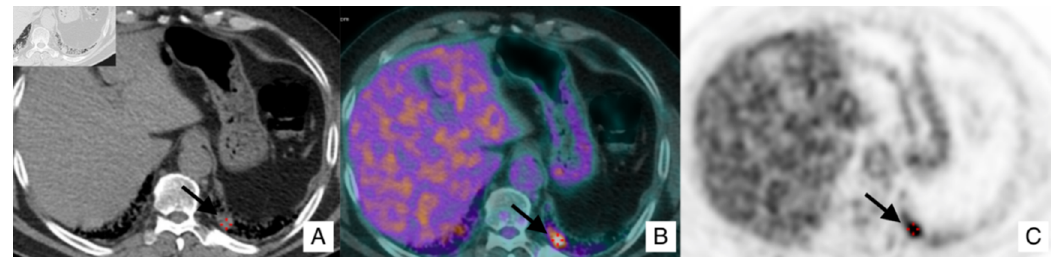
Figure 8. PET-CT ( A – C ) of the same patient of Figures 6 and 7. The exam demonstrates an increased activity (uptake of 6.84) in the nodular lesion, which is clearly depicted (black arrow) in the axial CT image ( A ), in the fusion colour image ( B ) and in the black and white PET map ( C ).